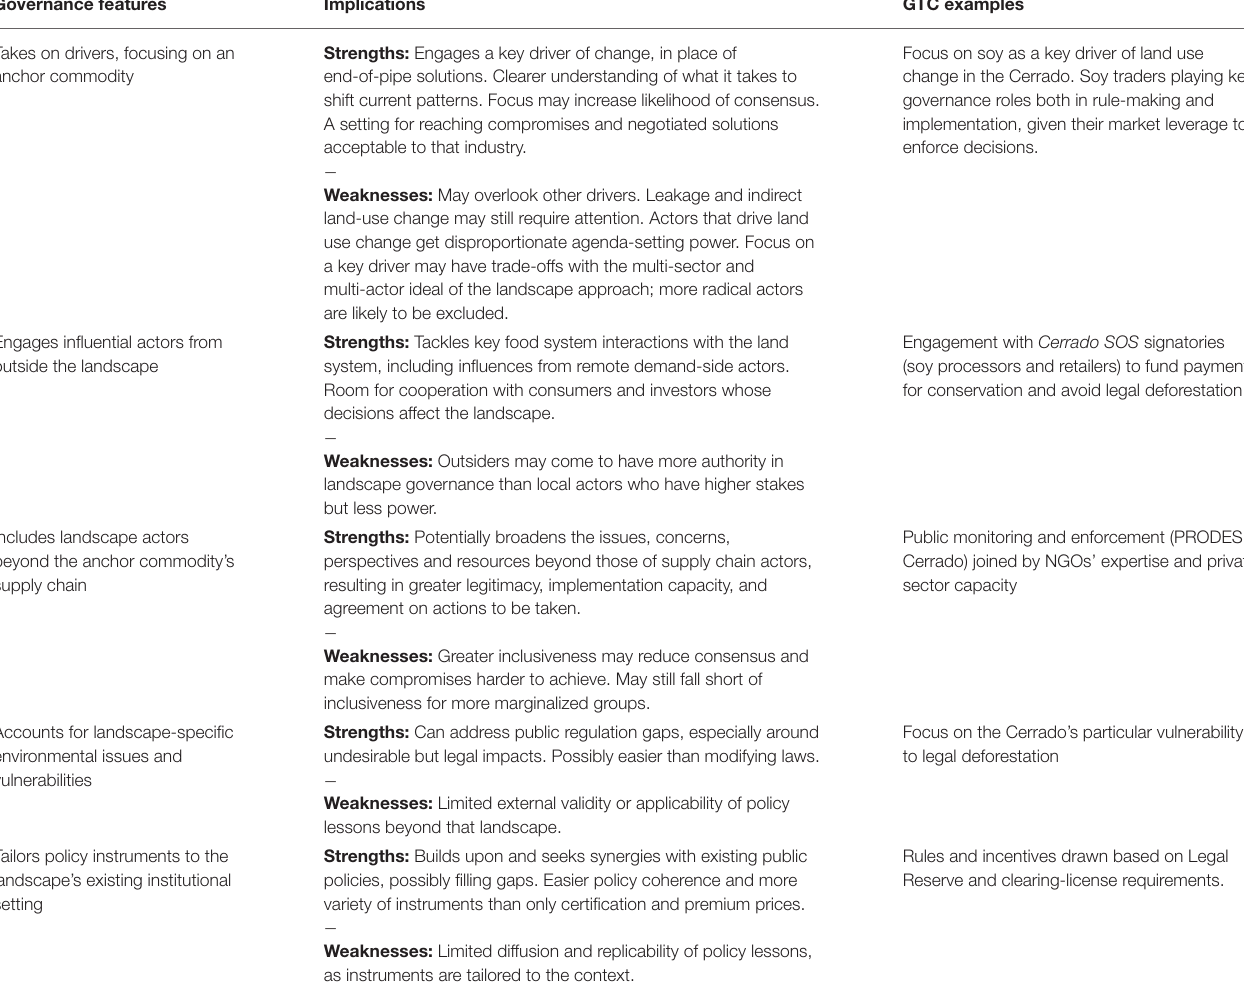
TABLE 3 | Summary of CCLG’s hybrid